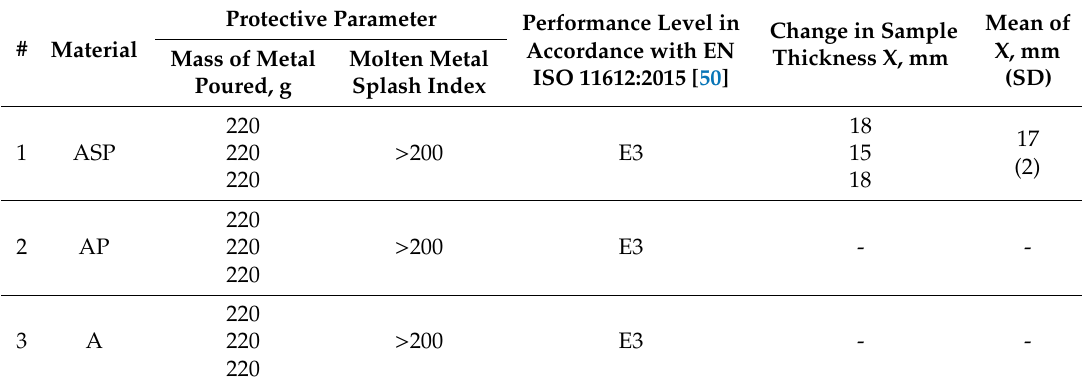
Table 7. Test results of resistance to molten iron splash in accordance with EN ISO 9185:2007 [55]: